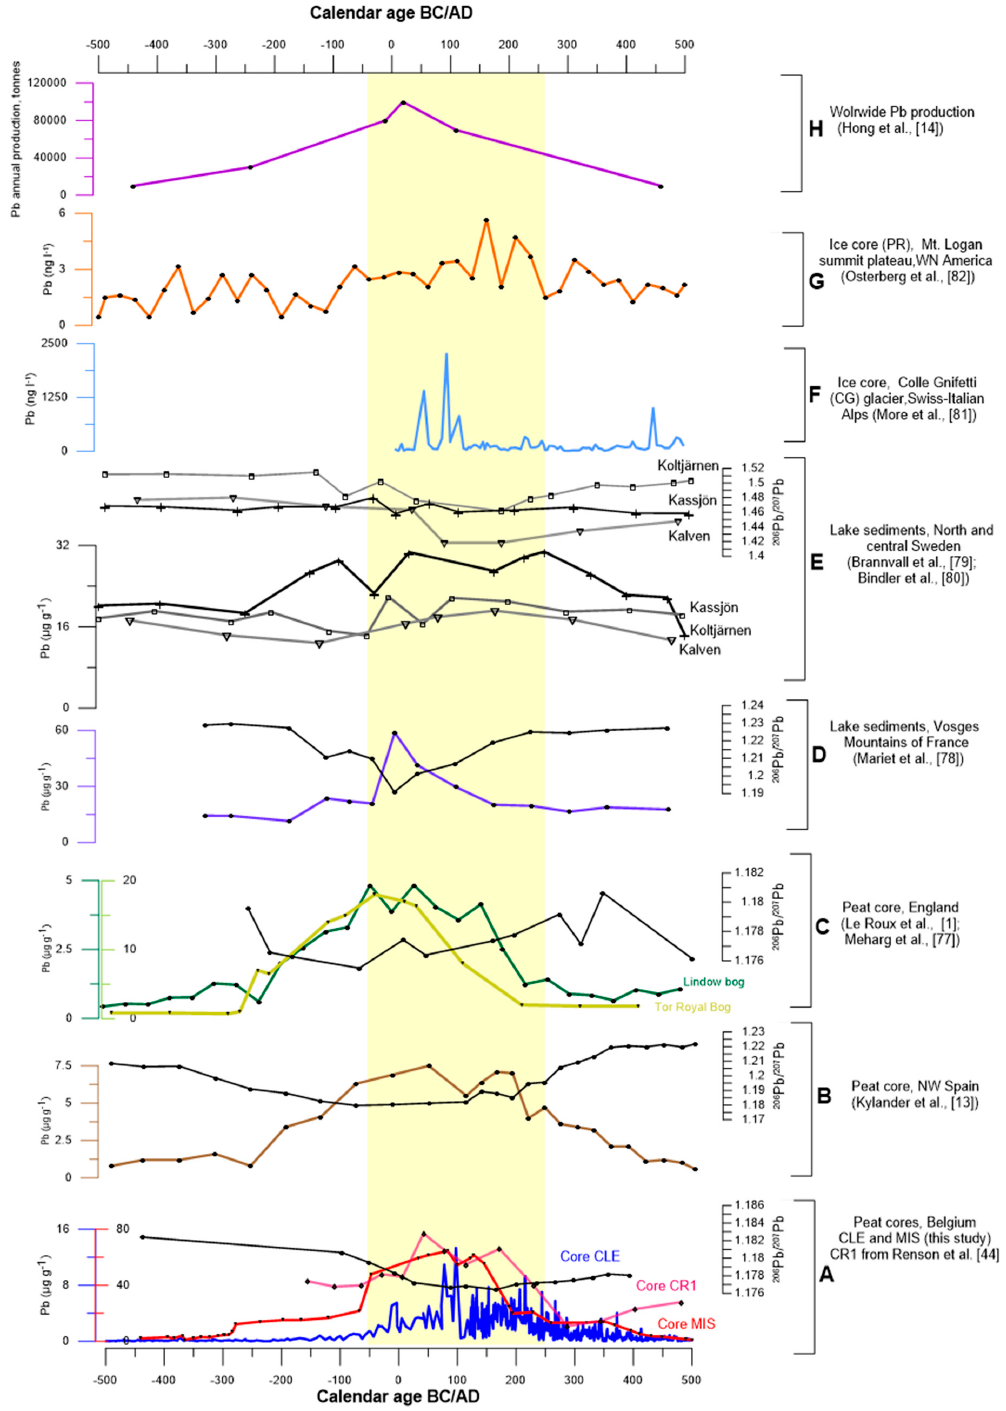
Figure 6. Pb concentrations and 206 Pb/ 207 Pb ratio record from: A . Belgian peat cores for the period from 500 BC to AD 500 [44], B . NW Spain peat core [13], C . England peat cores [1,77], D . French lake sediments [78], E . Swedish lake sediments [79,80], F . Suiss ice core [81], G . Canadian ice core [82]. The historical production of lead ( H ) during Roman period [14].Yellow zone corresponds to zenith Roman Empire.